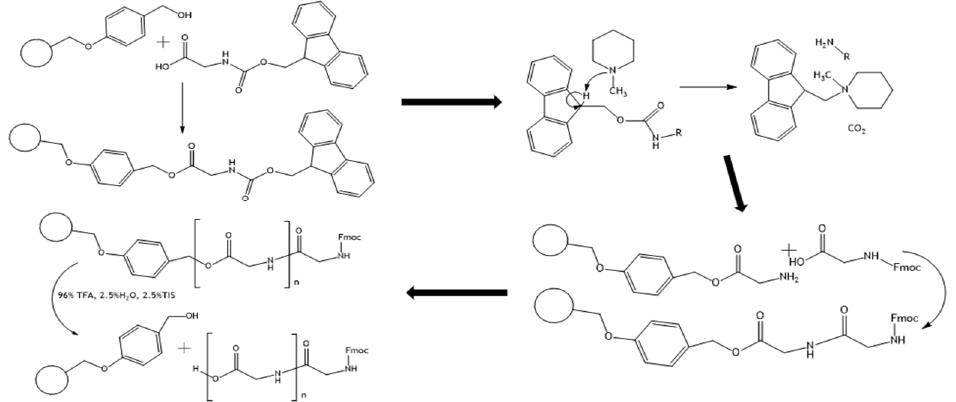
Figure 3. Scheme of solid phase synthesis of triglycine.